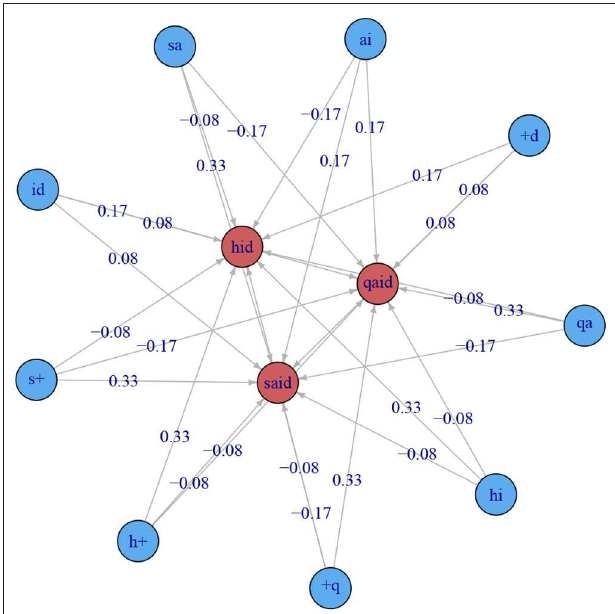
FIGURE 3 | The two-layer network corresponding to W . The outer vertices in blue represent the input nodes, the inner vertices in red represent the output nodes. All input nodes are connected to each of the three output nodes. Each edge in the graph is associated with a weight which specifies the support that an input node provides for an output